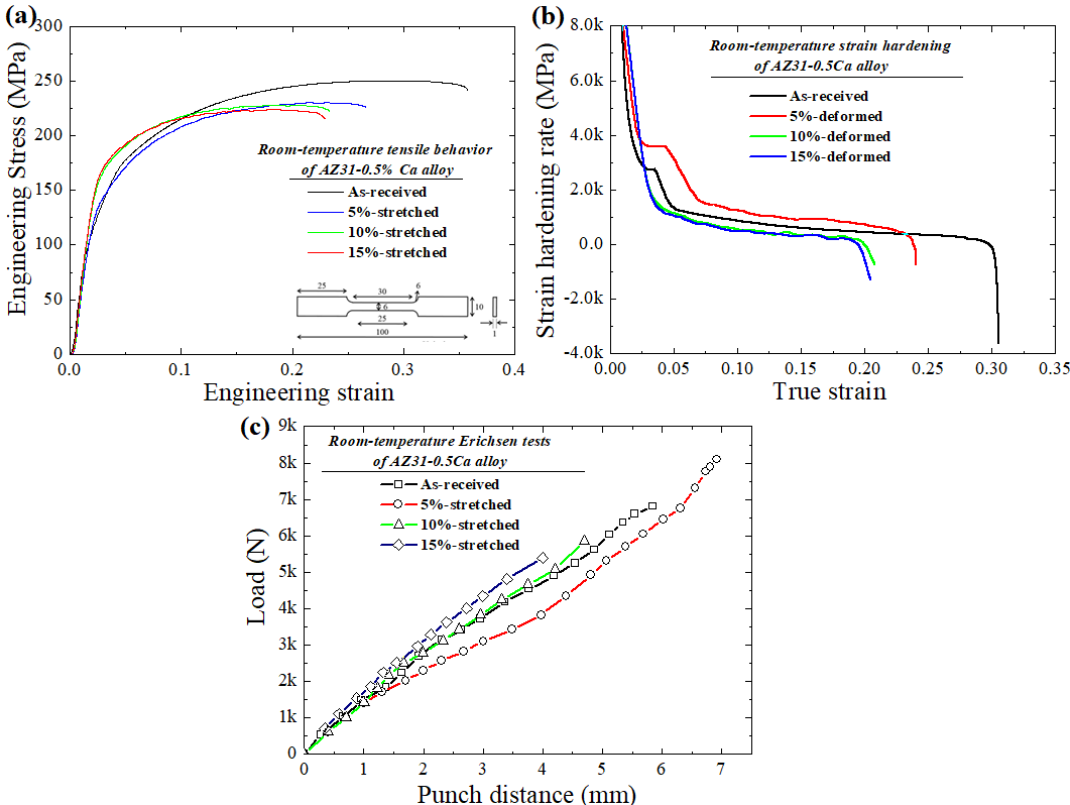
Figure 4. ( a ) Room-temperature tensile curves (figure inset in ( a ) shows the dimensions of the tensile samples); ( b ) strain hardening behavior, and ( c ) Erichsen cupping test curves of the as-received and pre-stretched (5%, 10% and 15%)